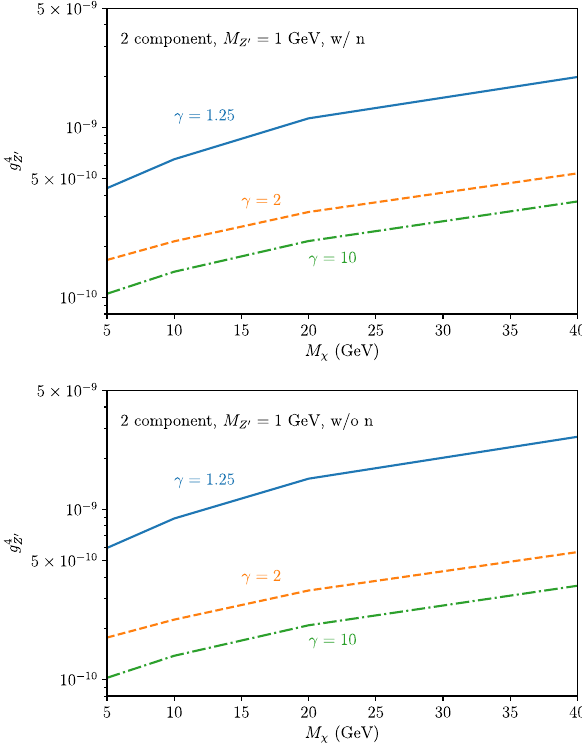
Fig. 25 Angular distribution of the BDM signal events for a BDM mass of 10GeV and different boosted factors, γ , and of the atmospheric neutrino NC background events. θ represents the angle of the sum over all the stable final state particles as detailed in the text. The amount of backgroundrepresents1-yeardatacollection,magnifiedbyafactor100, while the amount of signal reflects the detection efficiency of 10,000 MC events. The top plot shows the scenario where neutrons can be reconstructed, while the bottom plot represents the scenario without neutrons